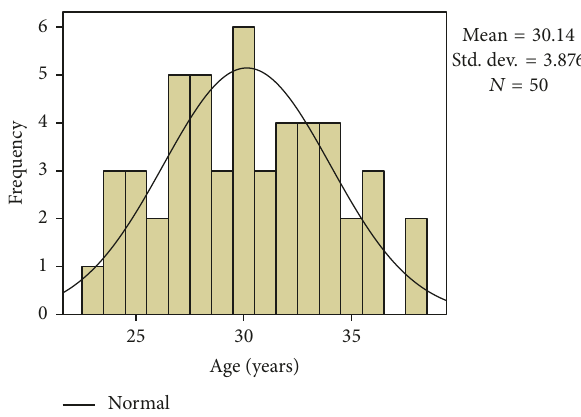
Figure 1: Histogram showing age